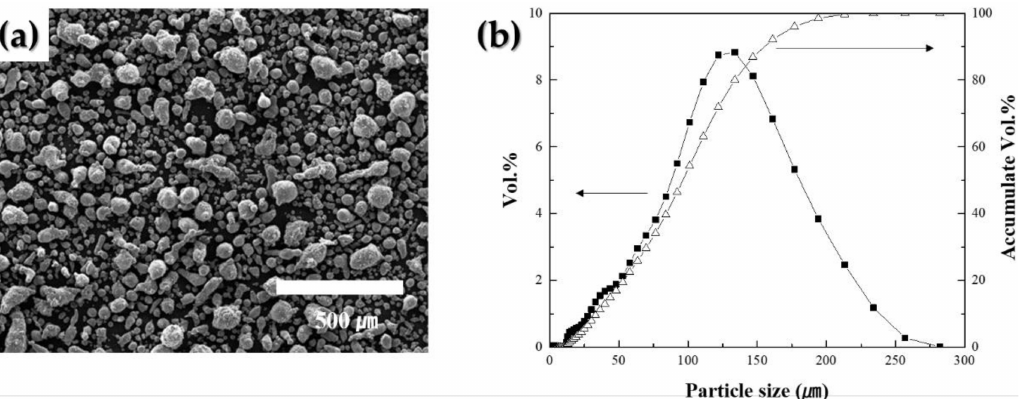
Figure 3. ( a ) scanning electron microscope (SEM) image of Al3003 powder and ( b ) Typical Particle size analysis (PSA) graph (black squares) and accumulate PSA graph (outlined triangles) of the Al3003 powder used in this study.